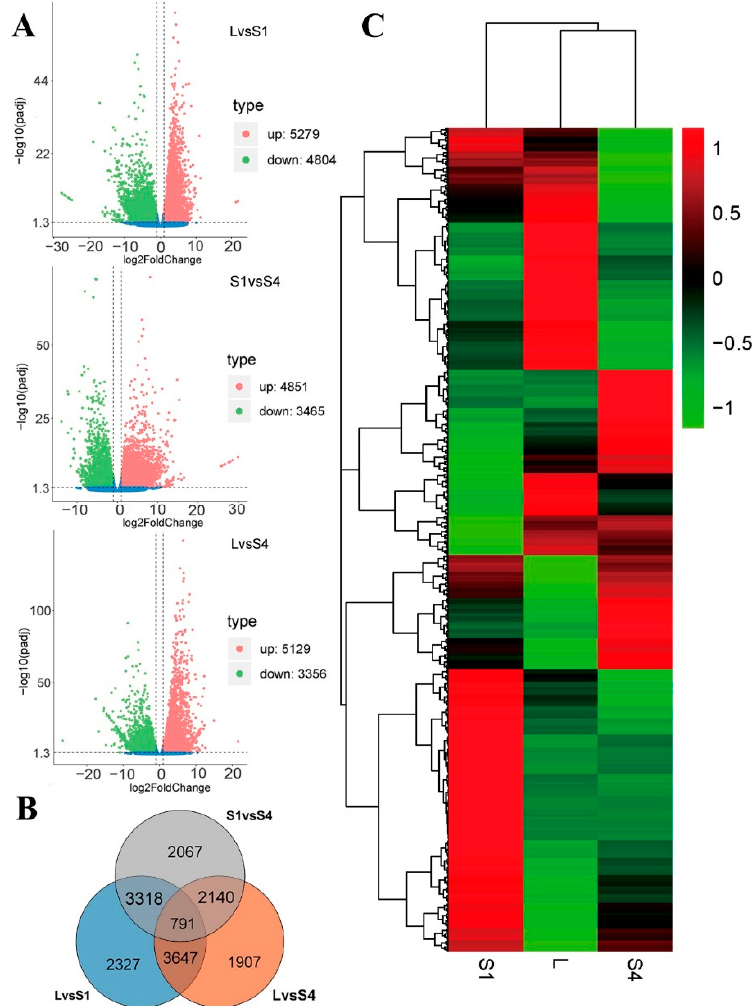
Figure 2. Analysis of DEGs in T. coccineum . ( A ) Volcano plots for LvsS1, LvsS4, and S1vsS4, from top to bottom; vertical dotted lines indicate a Log 2 fold change of 1, horizontal dotted line indicates an adjusted p-value of 0.05 ( B ) Venn diagram showing the numbers of identified DEGs for LvsS1vsS4; ( C ) heat map of DEG clusters.